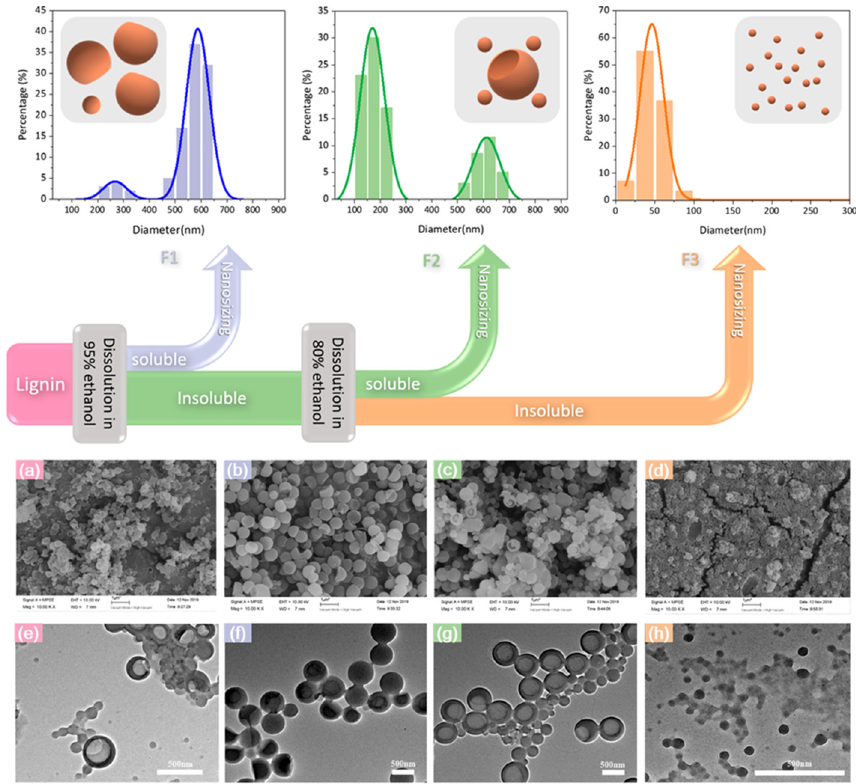
Figure 3. Lignin fractionation is proposed as an efficient way to reduce heterogeneity in lignin self-assembly nanosizing and produce uniform lignin nanoparticles with small size; SEM images of LMNPs prepared from EHL ( a ), F1 ( b ), F2 ( c ), and F3 ( d ); TEM images of LMNPs prepared from EHL ( e ), F1 ( f ), F2 ( g ), and F3 ( h ). Reprinted with permission from Ref. [17]. Copyright 2020 American Chemical Society.